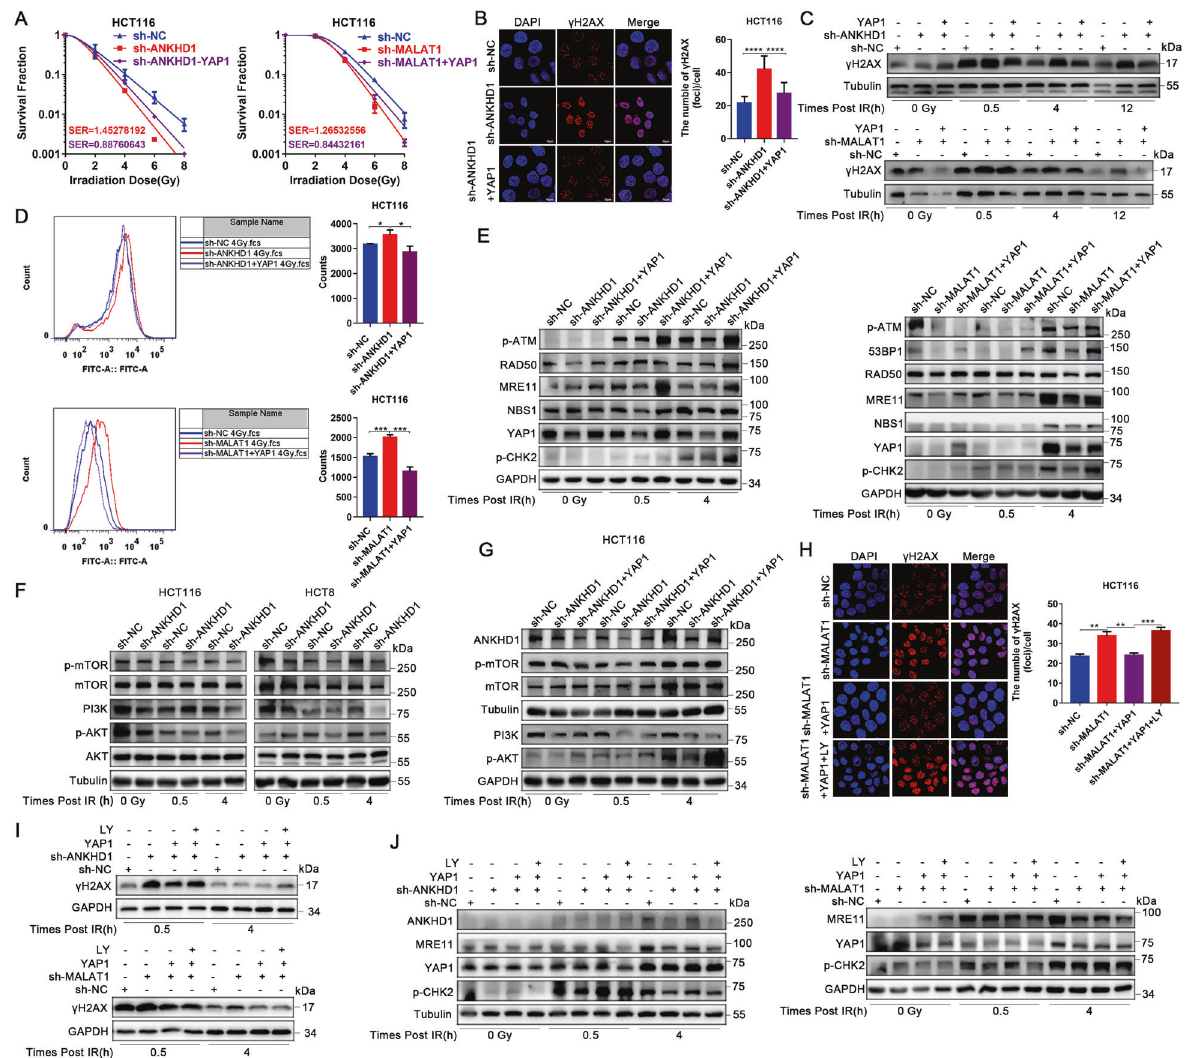
Fig. 7 YAP1/AKT axis is essential for ANKHD1/MALAT1-mediated radioresistance of CRC cells. A Overexpression of YAP1 abrogated radiosensitivity in sh-ANKHD1 or sh-MALAT1 cells. B , H Overexpression of YAP1 reduced the large number of γ H2AX foci induced by ANKHD1 silencing or MALAT1 silencing at 0.5 h post IR (** P < 0.01). C γ H2AX was also tested by Western blotting at 0, 0.5, 4, and 12 h post IR. D Overexpression of YAP1 decreased the formation of ROS caused by ANKHD1 silencing or MALAT1 silencing at 0.5 h post IR (* P < 0.05). E Overexpression of YAP1 recovered the expression of p-ATM, 53BP1, RAD50, MRE11, NBS1, and p-CHK2 in ANKHD1-silenced cells or MALAT1- silenced cells after 0.5- and 4-Gy IR. F ANKHD1 silencing inhibited the activation of the PI3K/AKT signaling pathway with or without IR. G Overexpression of YAP1 reactivated the PI3K/AKT signaling pathway. H , I Treatment with the PI-3 kinase inhibitor LY294002 abrogated the effect of YAP1 on the expression of γ H2AX in sh-ANKHD1 or sh-MALAT1 cells. J Western blot results showed that inactivation of AKT caused by LY294002 markedly decreased YAP1-induced upregulation of MRE11 and phosphorylation of the checkpoint protein CHK2 at 0.5 and 4 h post